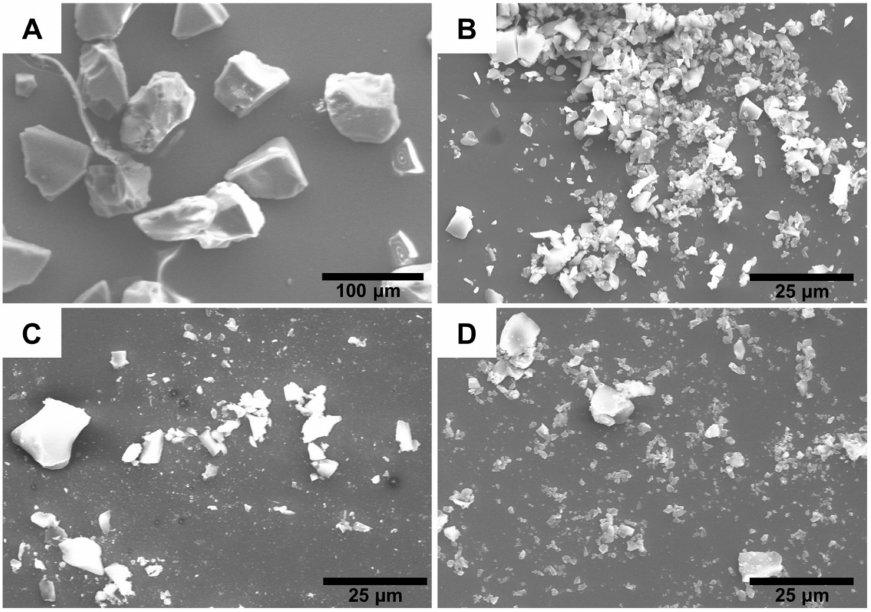
Figure 3. SEM images of ( A ) Si, ( B ) Si-Py + , ( C ) NCTPP-Si and ( D ) NCTPP-Si-Py + .